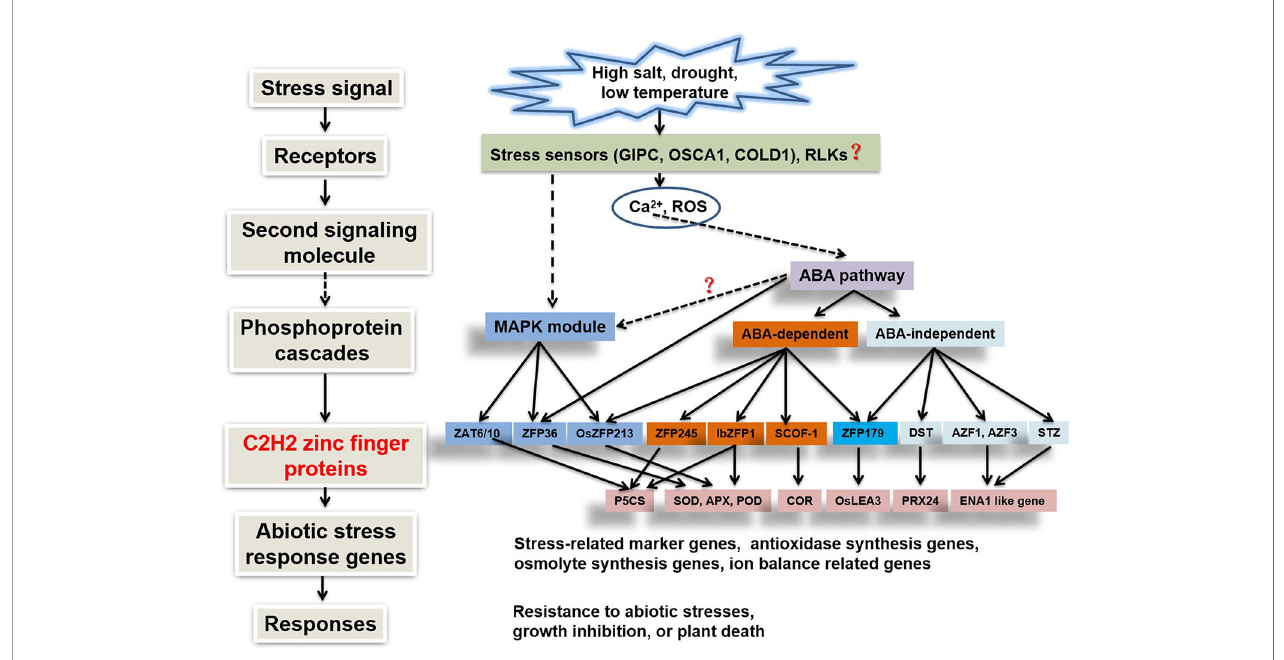
FIGURE 2 | Signaling pathways of C2H2-type zinc fi nger protein genes involved in abiotic stress responses (Xiong et al., 2002; Wang et al.,